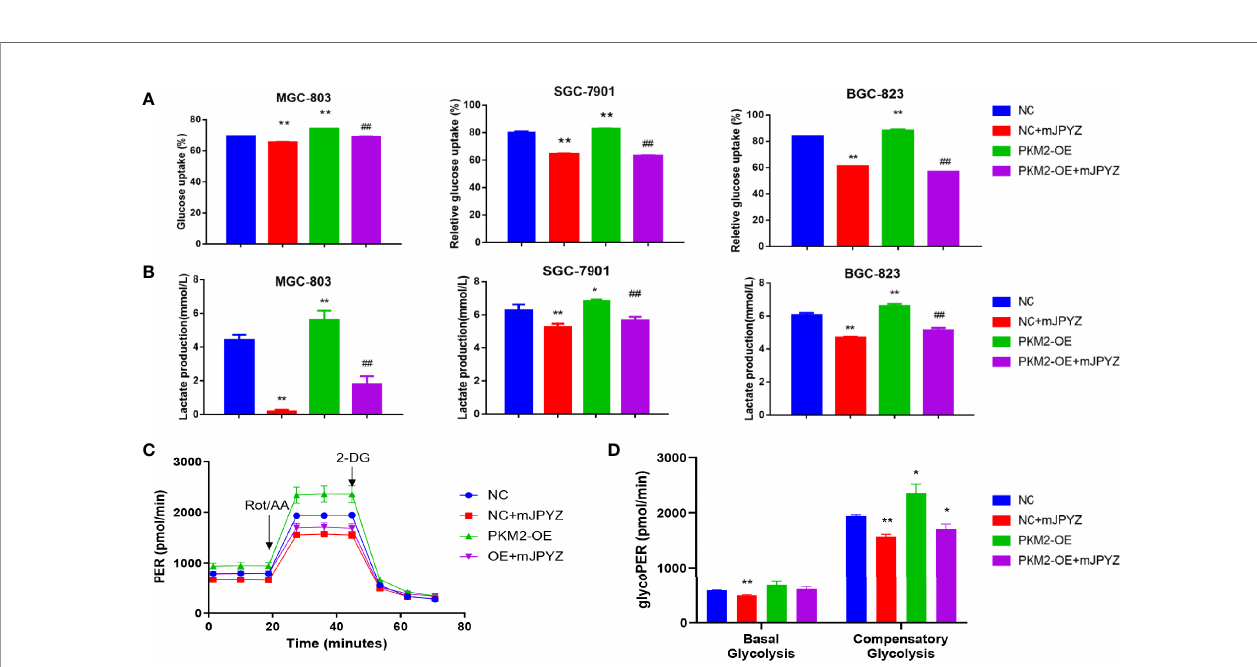
FIGURE 5 | mJPYZ modulated PKM2 and in fl uenced gastric cancer aerobic glycolysis. (A, B) The effects of mJPYZ on the glucose uptake and lactate production levels in Negative Control (NC) and PKM2 overexpression gastric cancer cells. (C, D) Extracellular acidi fi cation rates (ECAR) and Proton Ef fl ux Rate (PER) were measured in gastric cancer cells by Seahorse XFe assays. mJPYZ administration decreased ECARs, PER, glucose consumption and lactate production in NC or PKM2-OE compared with untreated control. Data are represented as mean ± SD, n=3 independent experiments. *P < 0.05, **P < 0.01 versus NC group, ## P < 0.01 versus PKM2-OE group by one-way analysis of variance (ANOVA) followed by Tukey ’ s post-hoc